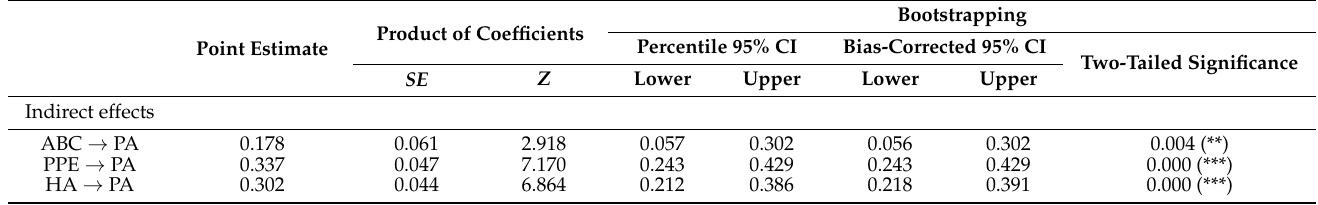
Table 4. Standardized indirect